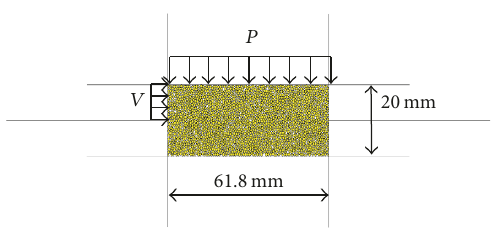
Figure 11: Direct shear model of the mudded weak interlayer in PFC